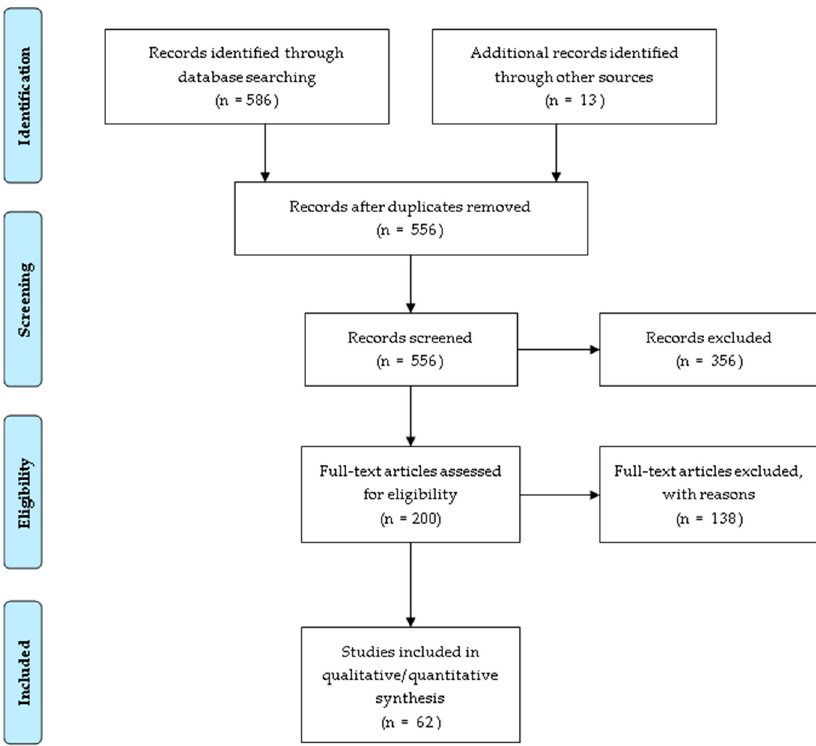
Figure 2. PRISMA flow diagram of our survey methodology.